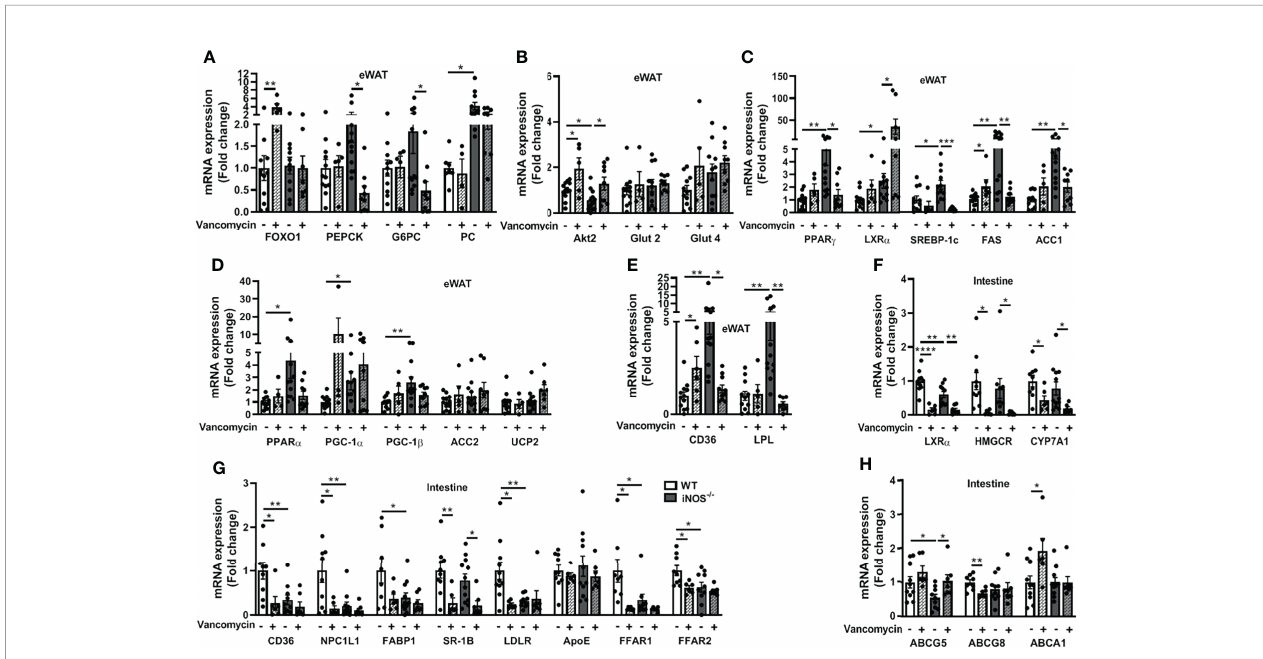
FIGURE 5 | Improvement in the disrupted lipid and glucose homeostasis in adipose tissue and intestine in iNOS − / − mice following treatment with vancomycin. Adipose tissue mRNA expression analysis of genes involved in (A) gluconeogenesis, (B) glucose homeostasis, (C) lipid synthesis, (D) lipid oxidation, and (E) lipid uptake. Intestinal tissue mRNA expression analysis of genes involved in (F) lipid synthesis, (G) lipid uptake, and (H) lipid ef fl ux. Data are represented as mean ± SEM ( n ≥ 6). * p < 0.05, ** p < 0.01, *** p < 0.001, **** p < 0.0001 between indicated groups. See also Figures S8, S9